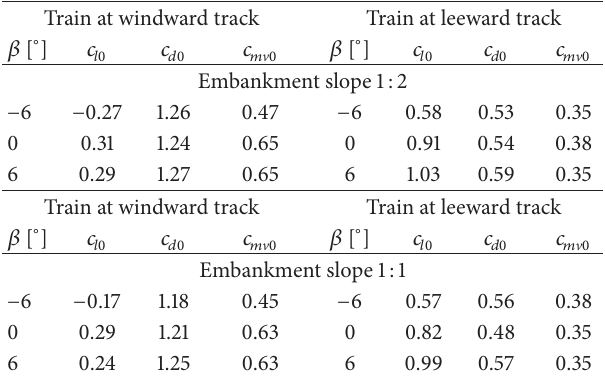
Table 2: Force coefficients, 𝑐 𝑙0 , 𝑐 𝑑0 , and 𝑐 𝑚 V 0 , corresponding to the configurations tested without parapets ( ℎ = 0 ). The reference axes are shown in Figure 1.